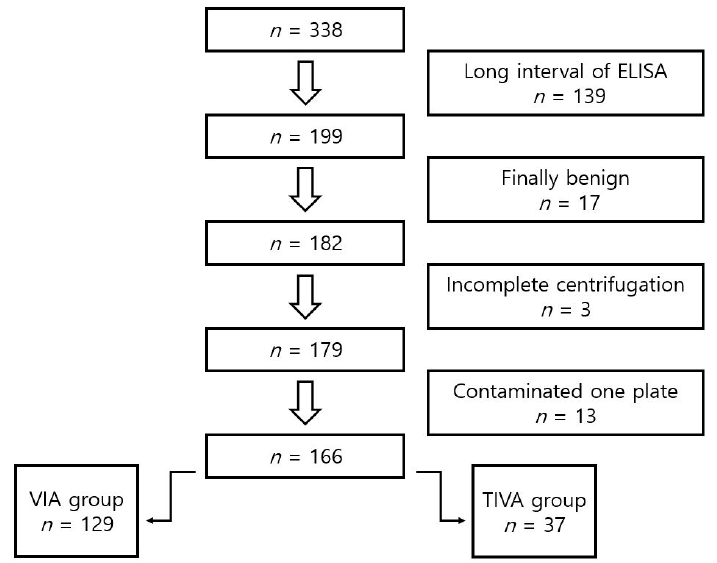
Figure 1. Patient flow chart. Table 2. Patient demographic data and anesthesia information